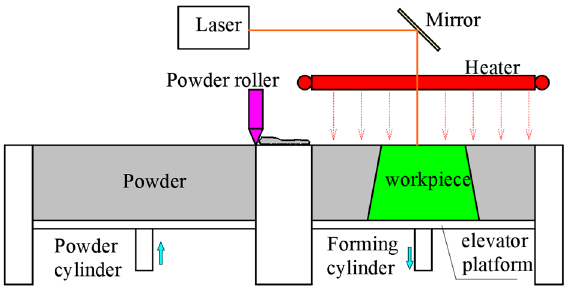
Figure 1. Schematic diagram of the selective laser sintering.